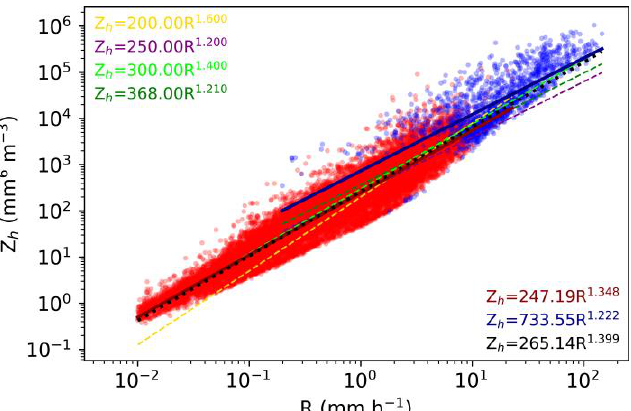
Figure 8. Scatterplot of 𝑍 ℎ (mm 6 m – 3 ) vs. 𝑅 (mm h – 1 ) computed from PARSIVEL 2 DSD measurements for stratiform (red dots) and convective (blue dots) rain classified using BR09 scheme. The fitted power-law curves for stratiform and convective rain, as well as the entire dataset, are indicated by thick solid dark-red, solid dark-blue, and black dotted lines, respectively. The relationships for continental stratiform rain, 𝑍 ℎ = 200𝑅 1.6 [58], tropical systems, 𝑍 ℎ = 250𝑅 1.2 [59], the operational WSR-88D, 𝑍 ℎ = 300𝑅 1.4 [60], and Meiyu convective rain, 𝑍 ℎ = 368𝑅 1.21 [11] are also indicated in thin dashed yellow, purple, lime and green lines, respectively. Equations are overlaid using the same color with the corresponding curves.